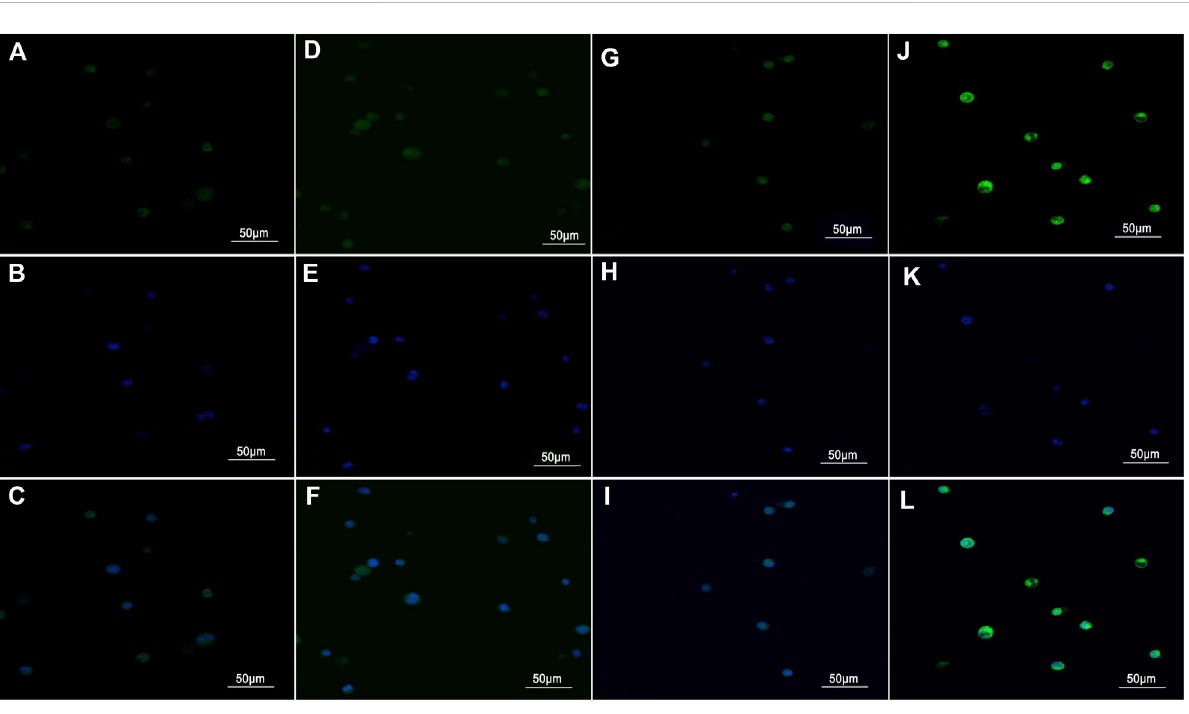
Figure 2. Weak green fl uorescence was observed in Hca-F cells with PLGA NPs and Hca-F cells with antibody blocking (Figures 2A,D). In addition, the Hca-F cells with GSN-PLGA